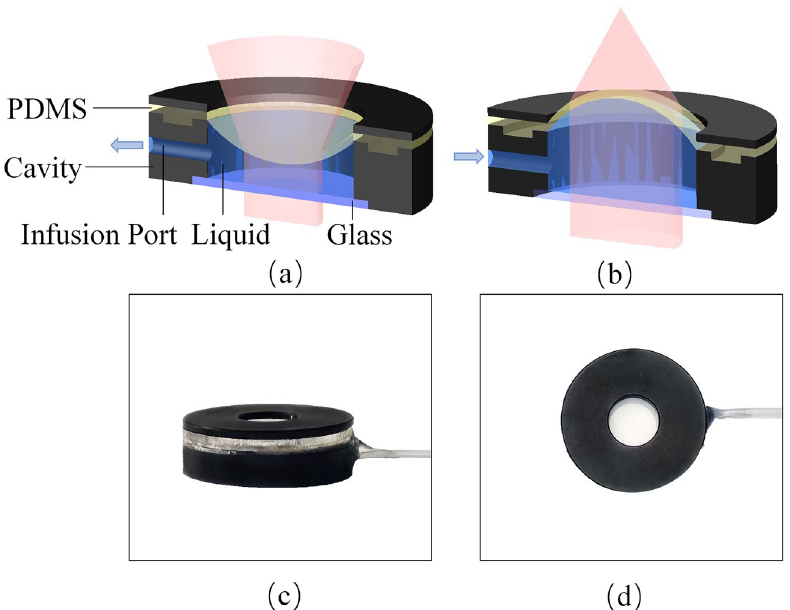
Figure 3. The schematic diagram and physical image of the proposed PDMS lens. ( a ) Divergence mode of the proposed PDMS lens. ( b ) Focus mode of the proposed PDMS lens. ( c ) Side view of the proposed PDMS lens. ( d ) Top view of the proposed PDMS